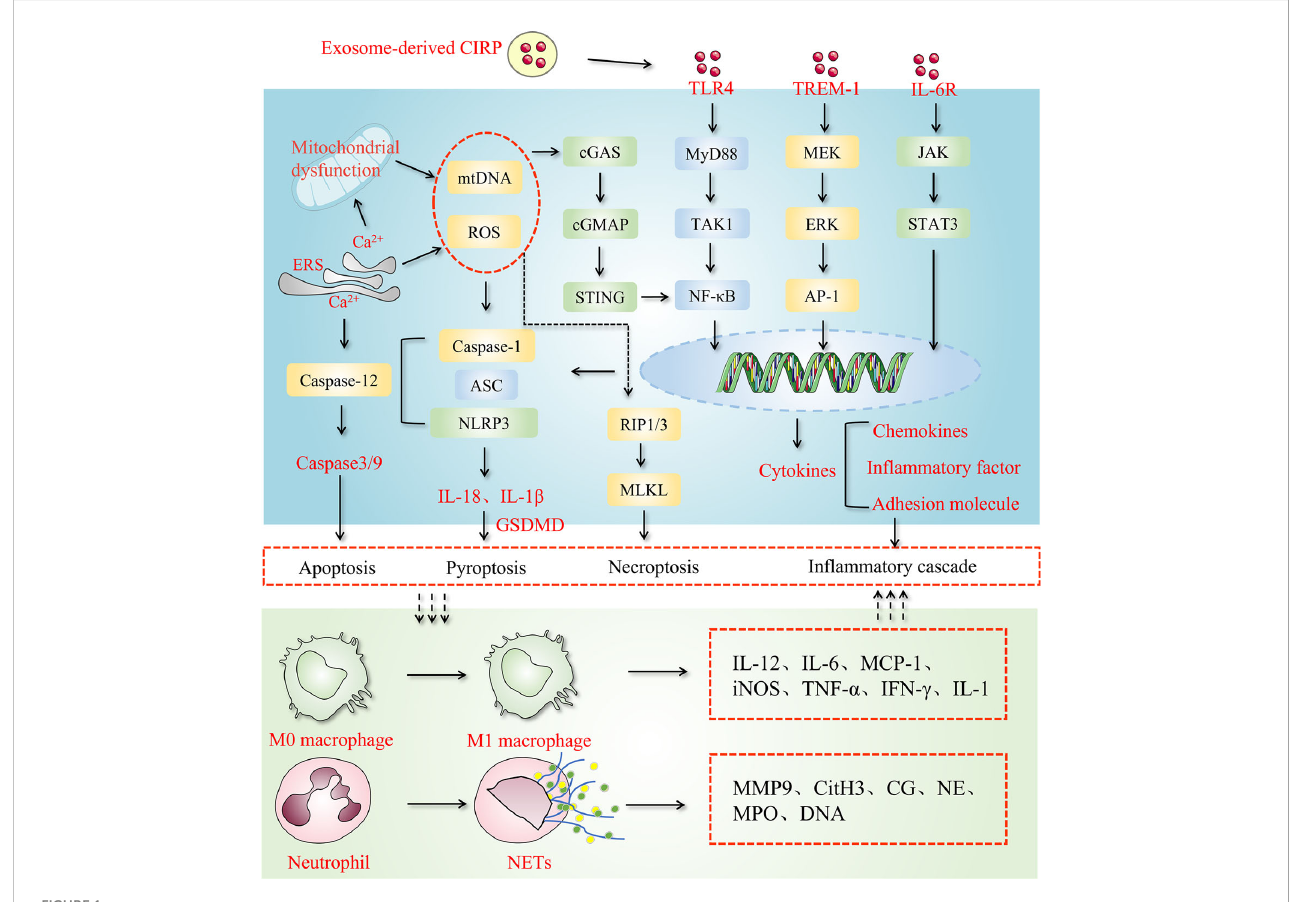
FIGURE 1 Exosome-derived CIRP: an ampli fi er of in fl ammatory